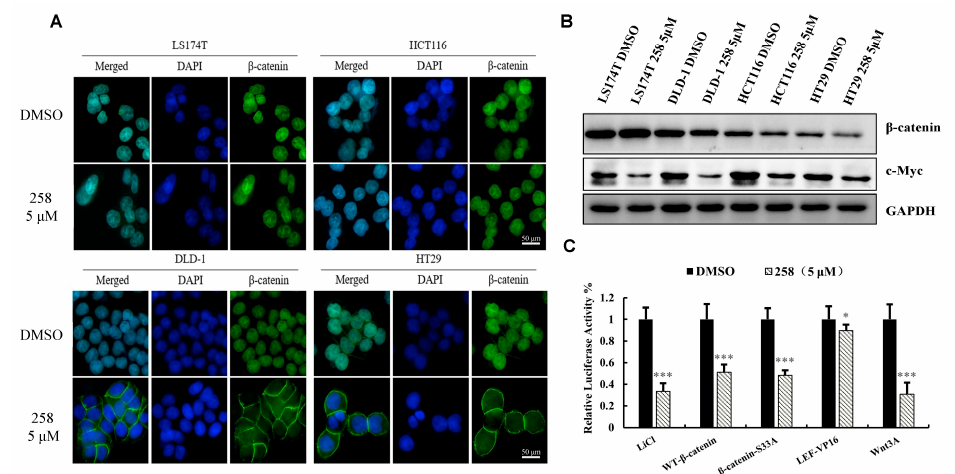
Figure 3. CX258 reduced nuclear β -catenin levels and Wnt target genes in CRC cells. ( A ) CRC cells were analyzed by β -catenin and DAPI immunocytochemical staining. CX258 reduced nuclear β - catenin levels in DLD-1 and HT29 cells (magni fi cation 400×). ( B ) E ff ects on CX258 on the protein levels of β -catenin and c-Myc. GAPDH was used as the loading control. ( C ) Wnt Reporter assays. CX258 inhibited TOPFlash reporter activities induced by Wnt3A, wild-type β -catenin and β -catenin (S33A) but was less effective in inhibiting the TOPFlash reporter induced by LEF-VP16 fusion protein. * p < 0.05, *** p < 0.001.